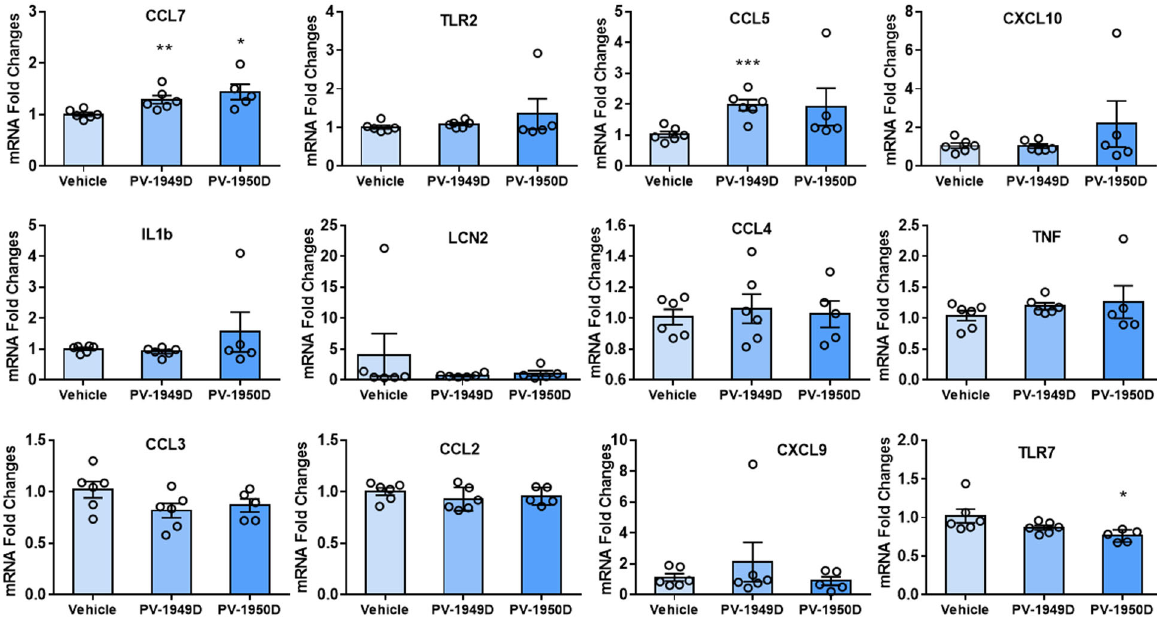
Fig. 10 Changes in the expression of molecules involved in the in fl ammatory pathway. Brains of mice vaccinated with PV-1949D and PV- 1950D were analyzed by